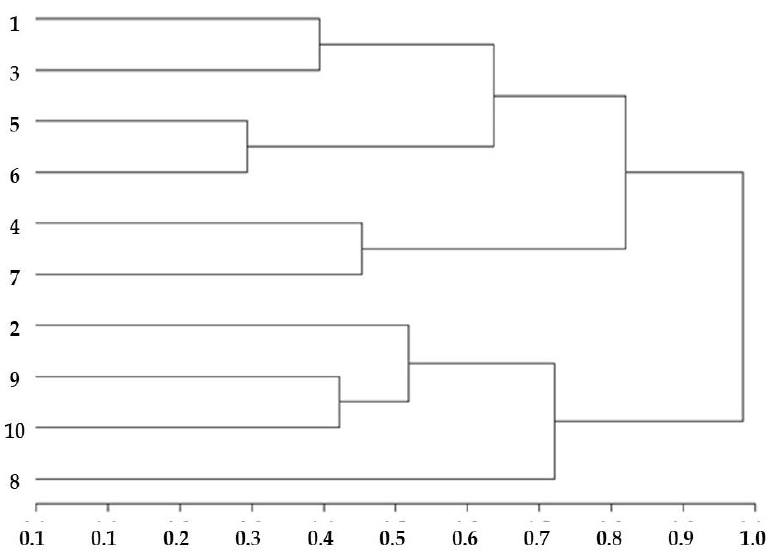
Figure 2. Dendrogram of treatments in Citrus limon and Citrus sinensis (graft / rootstock) plants. Uninfected ( − ) and infected ( + ) graft / rootstock, 1: − C. limon / C. aurantium ), 2: + C . limon / C. aurantium 3: − C. limon / C. macrophylla , 4: + C. limon / C. macrophylla , 5: − C . limon / C. volkameriana , 6: + C. limon / C. volkameriana , 7: − C. sinensis / C. aurantium , 8: + C. sinensis / C. aurantium , 9: − C. sinensis / C. volkameriana and